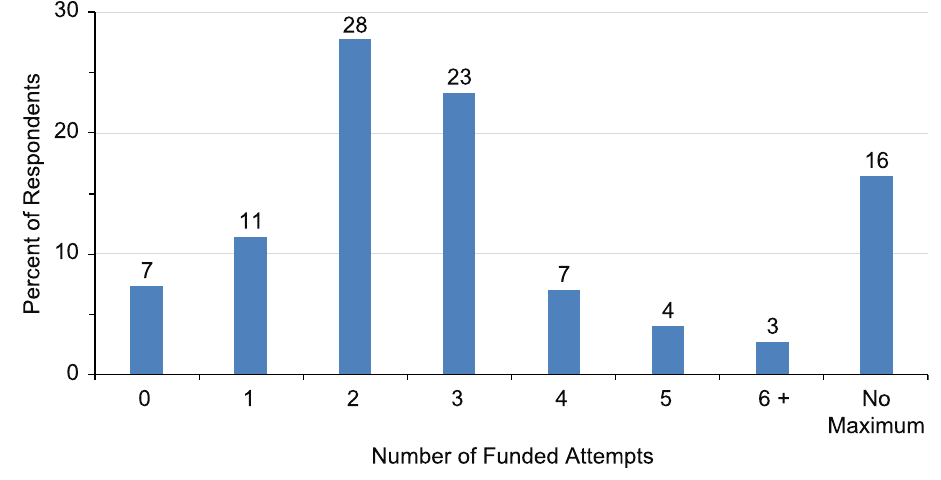
Fig 2. Opinions regarding the number of publicly funded IVF